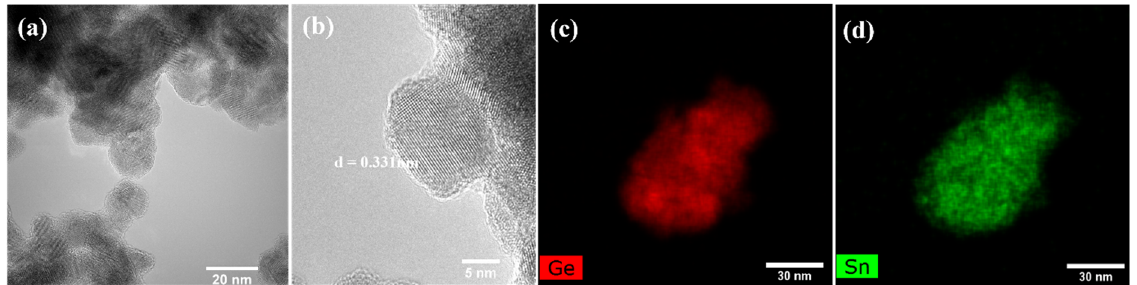
Figure 2. ( a ) HRTEM images of Ge 1 − x Sn x nanoparticles (x = 0.151). ( b ) HRTEM image of Ge 1 − x Sn x nanoparticles (x = 0.151), showing lattice fringes that correspond to the (111) plane of cubic Ge. ( c ) and ( d ) TEM/EDS elemental maps of Ge and Sn, respectively.